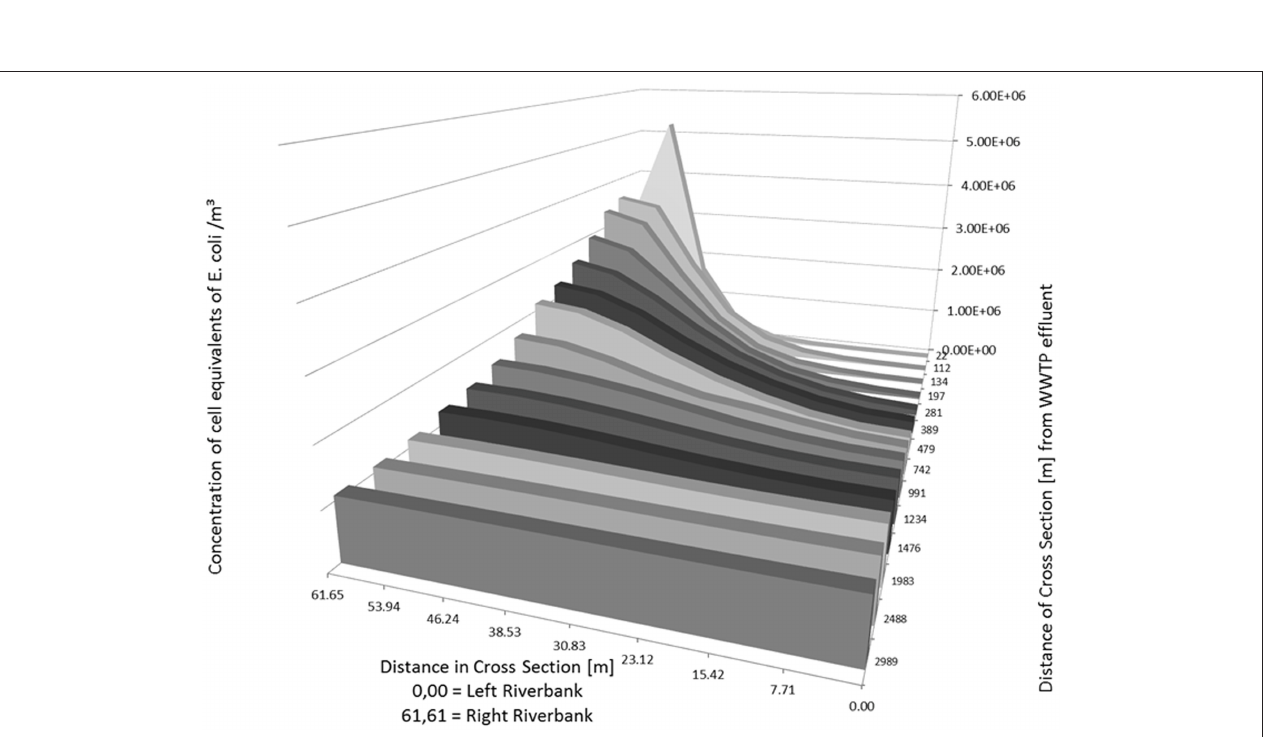
FIGURE 6 | Distribution of calculated (2D-HDWAM) concentration of E. coli in the river Danube downstream of the WWTP for different cross sections, 9.20 × 10 8 cell equivalents/m 3 in outlet of WWTP, discharge of Danube at 994 m 3 /s (HQ20).